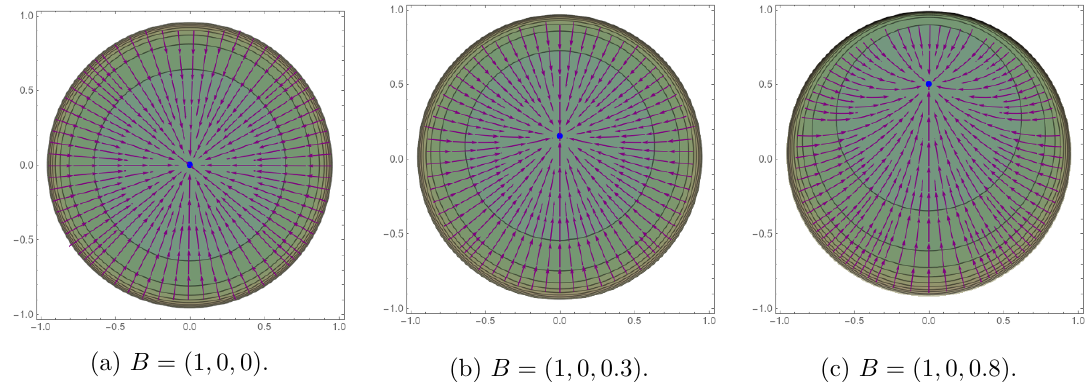
Figure 2. Contour plot of (cid:3) := (cid:3) 1 ; 0 ; (cid:1) for the non-degenerate timelike case ((cid:1) < 1), where the gradient (cid:13)ow of (cid:3) is indicated by purple arrows. The values of (cid:3) decrease from lightest brown to darkest green. The critical point of (cid:3) is shown in blue. In this case, the level sets are hyperbolic circles centered at the critical point. From left to right, the (cid:12)gure shows the cases (cid:1) = 0 ; 0 : 3 ; 0 : 8.